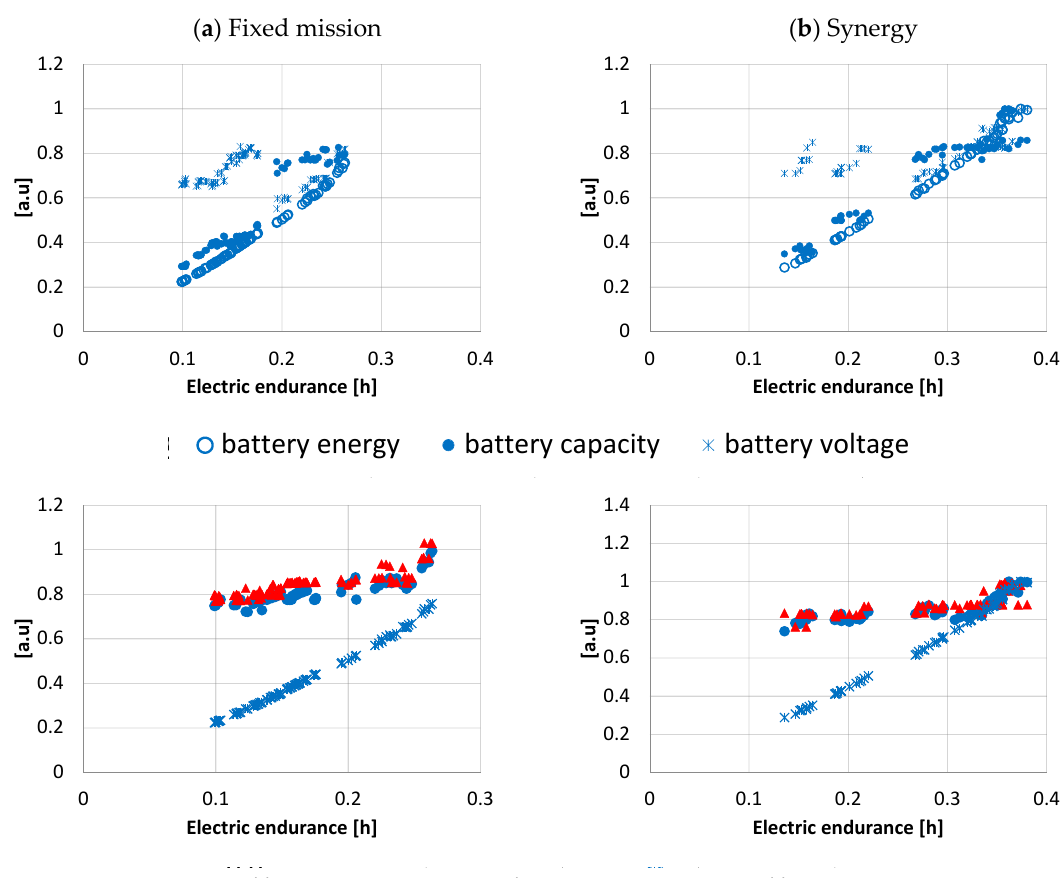
Figure 15. Trends of engine size and battery specifications along the Pareto front, for the fixed mission optimization (on the left) and synergy optimization (on the right).